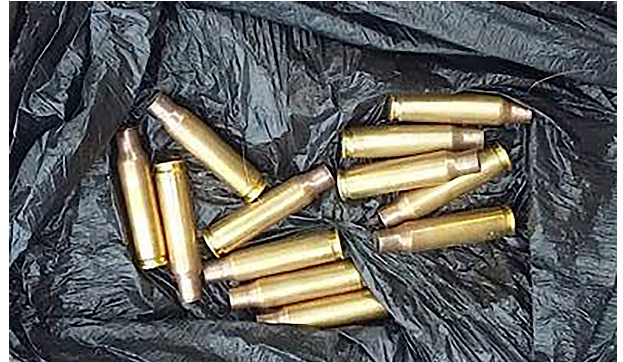
Figure 3. Spent shell casings collected from the ground after a police shooting in the Manguinhos favela, 2015.